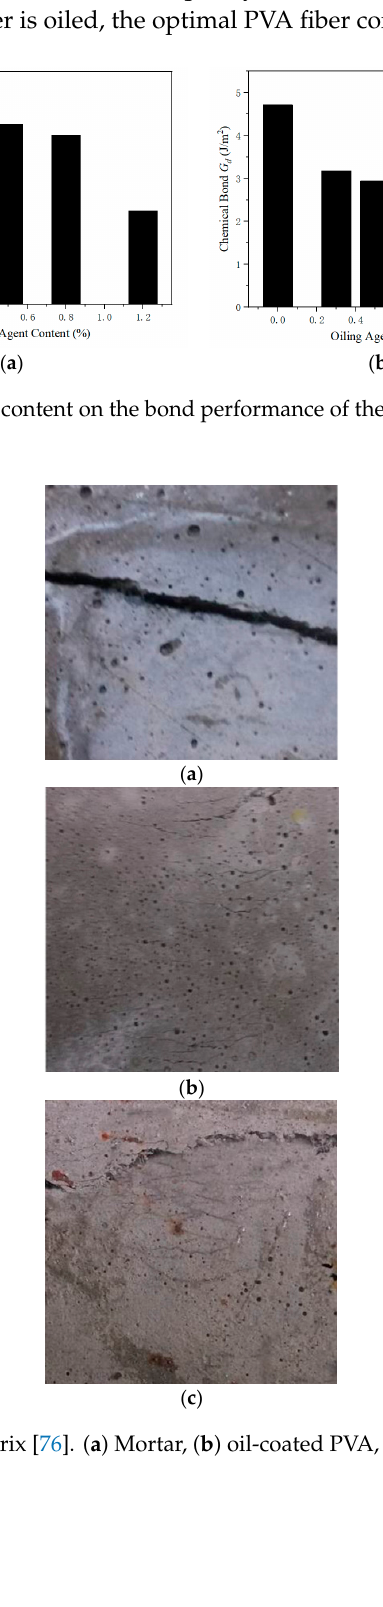
required to reduce the chemical bonding between the fiber and the surrounding cementitious